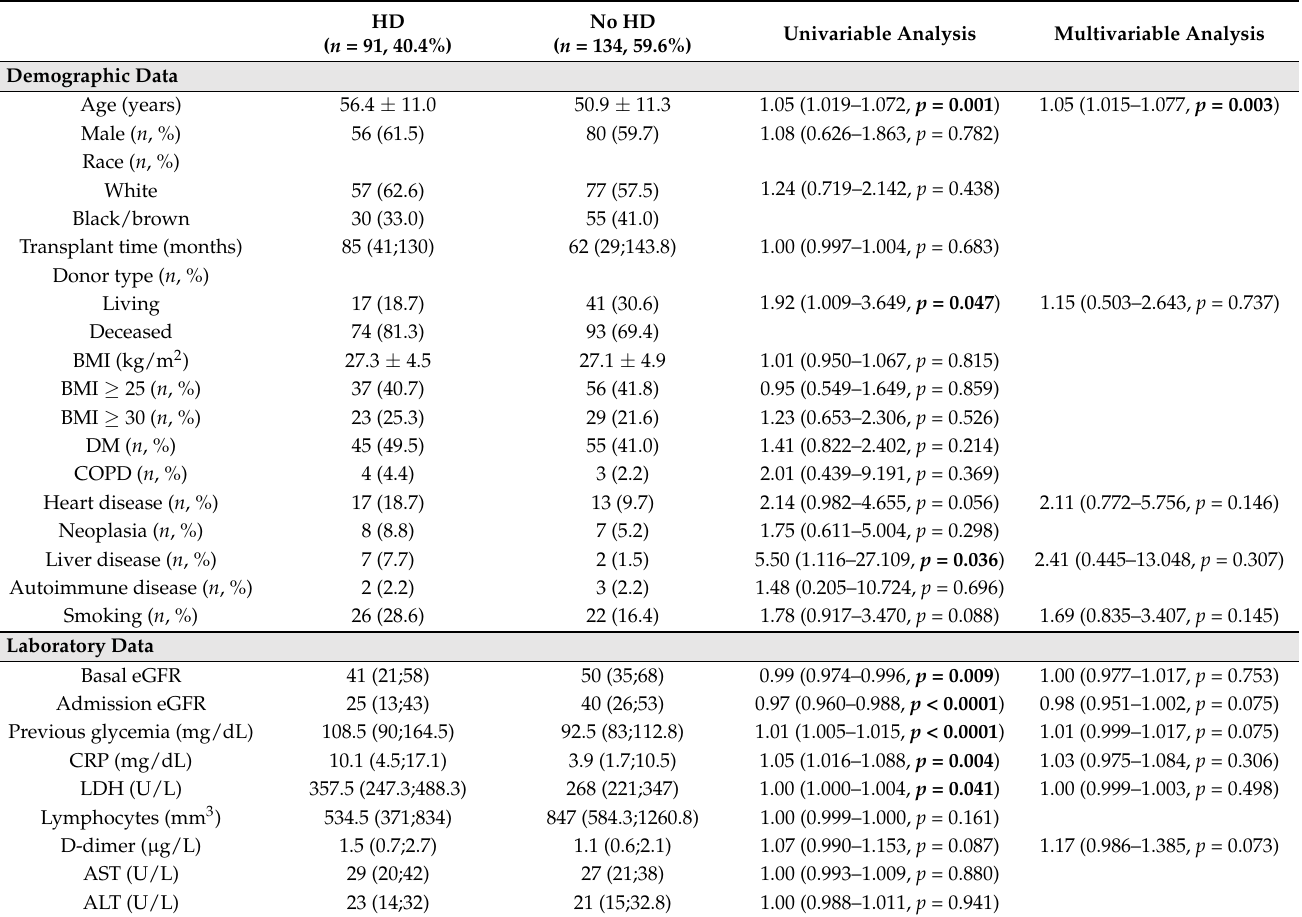
(93.4%) were transferred to the ICU, 77 (84.6%) needed IMV, and 66 (72.5%) died. Table 4. Risk factors for the need for hemodialysis (HD) in kidney transplant recipients with hyper- tension (HTN). HD No HD ( n = 91, 40.4%) ( n = 134,